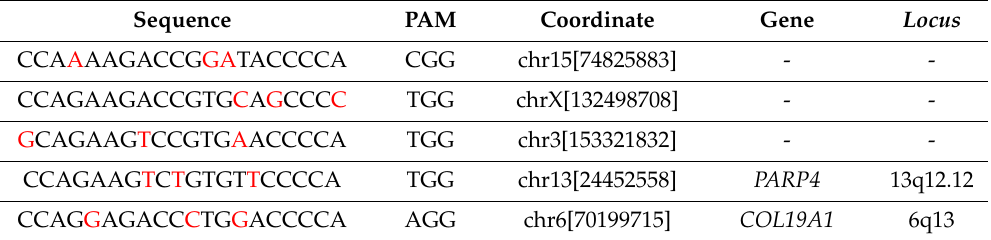
Nucleotides in red show the